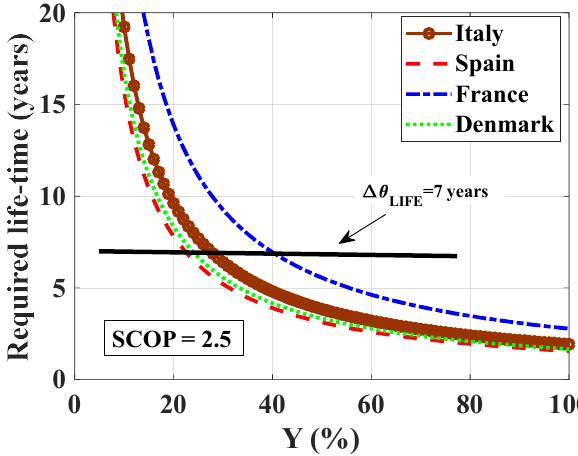
Figure 11. Required lifetime ( Δ tc = 0) as a function of the waste heat availability Y , for different countries according to their specific cost of the electric energy. The horizontal line refers to a realistic operating time of 7 years.